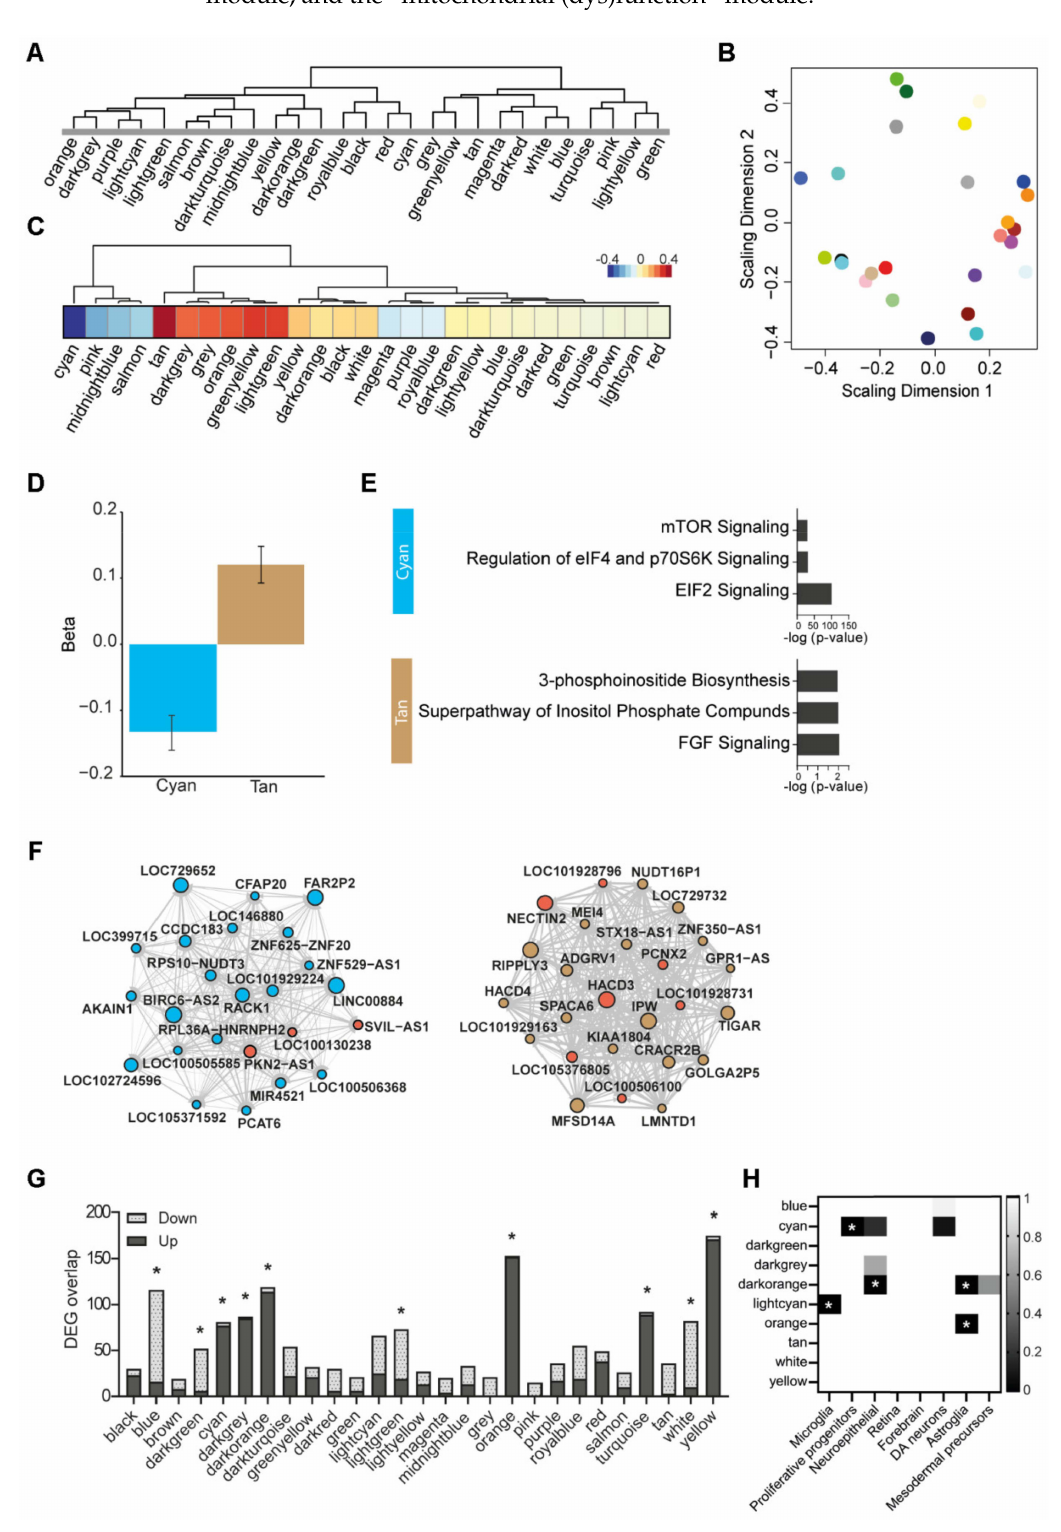
Figure 5. Gene network analysis of responses to AA exposure in cerebral organoids. ( A ) Tree